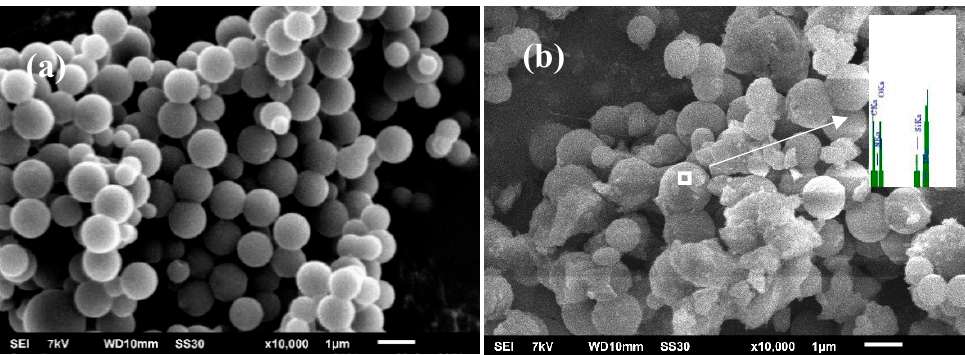
Figure 1. Scanning electron microscopy (SEM) and energy dispersive spectroscopy (EDS) images of carbon microspheres (CMSs) ( a ) and silane melamine phosphate carbon microspheres (SiMP-CMSs) ( b ).